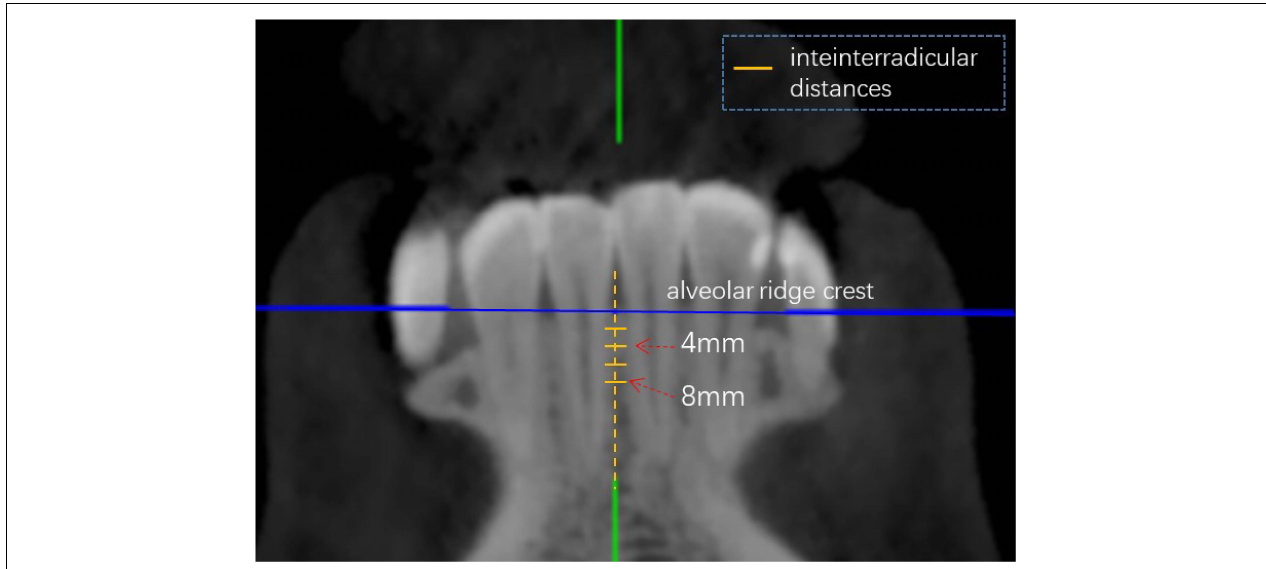
FIGURE 2 | CBCT measurement: interradicular distance in coronal